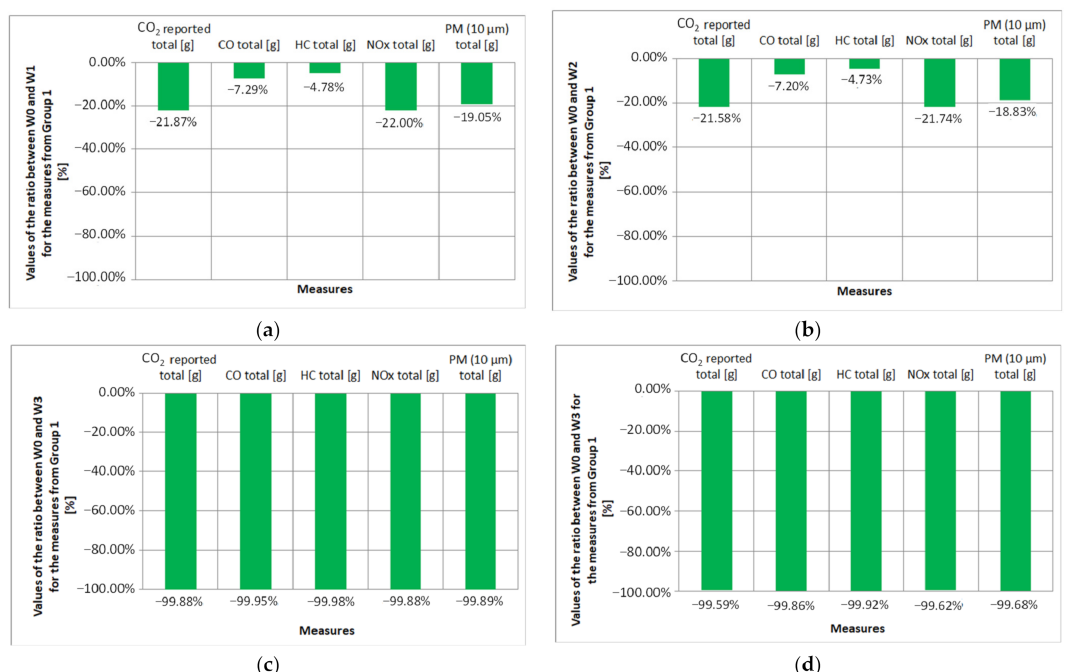
Figure 24. Values of the ratio between W0 and individual scenarios W1–W4 for the measures from Group 1—analysis for the central areas of the city: ( a ) the ratio between scenario W0 and W1; ( b ) the ratio between scenario W0 and W2; ( c ) the ratio between scenario W0 and W3; ( d ) the ratio between scenario W0 and